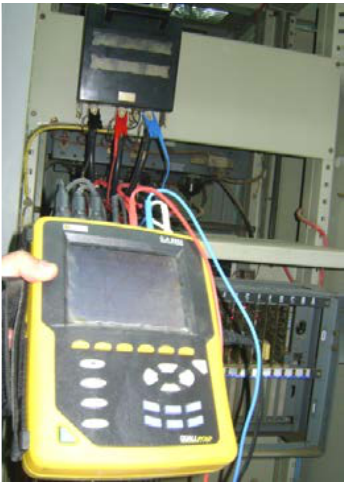
Figure 17. Power quality phenomena measurements using C.A